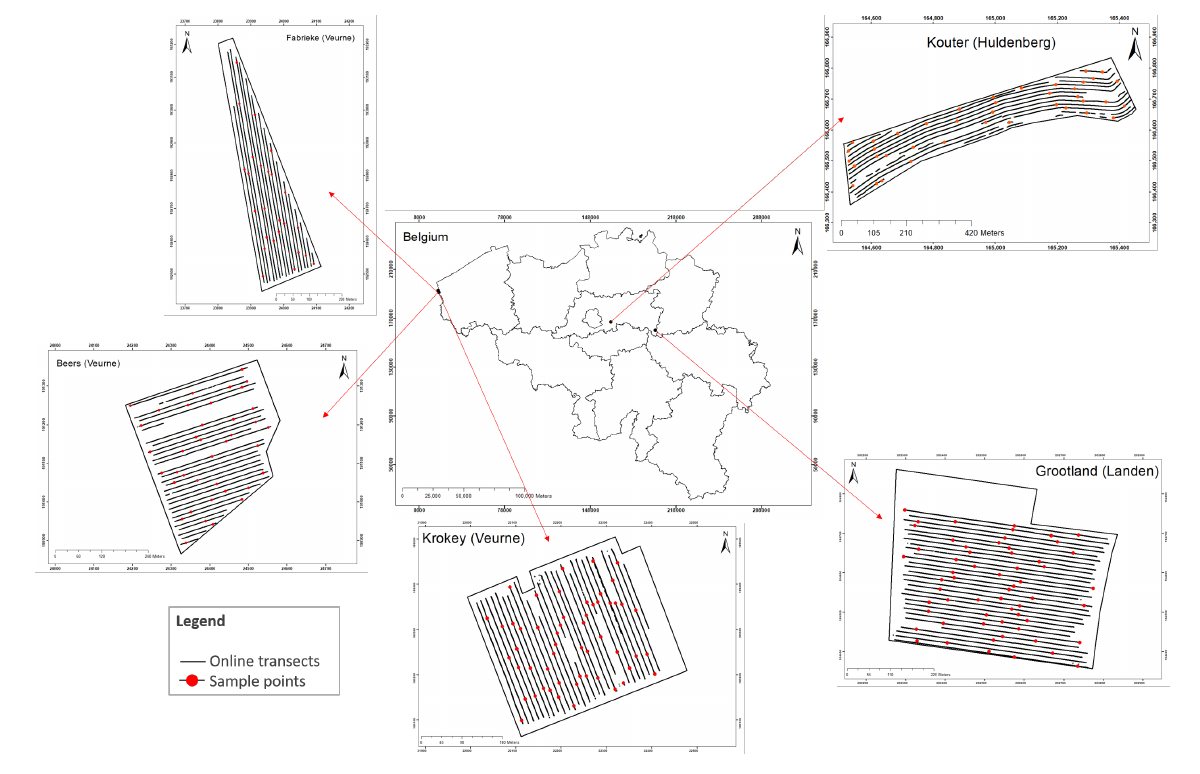
Figure 2. Locations of the five experimental sites in Flanders, Belgium, along with the online scanning lines and the locations of the random soil sampling points in Fabrieke, Beers, Krokey, Kouter, and Grootland. Table 1. Information of the spectral library used for the development of visible and near-infrared (vis-NIR) calibration models for three farms for the prediction of key soil properties using the online spectra collected with the online multi-sensor platform. Reprinted with permission from Ref. [11]. Copyright 2021